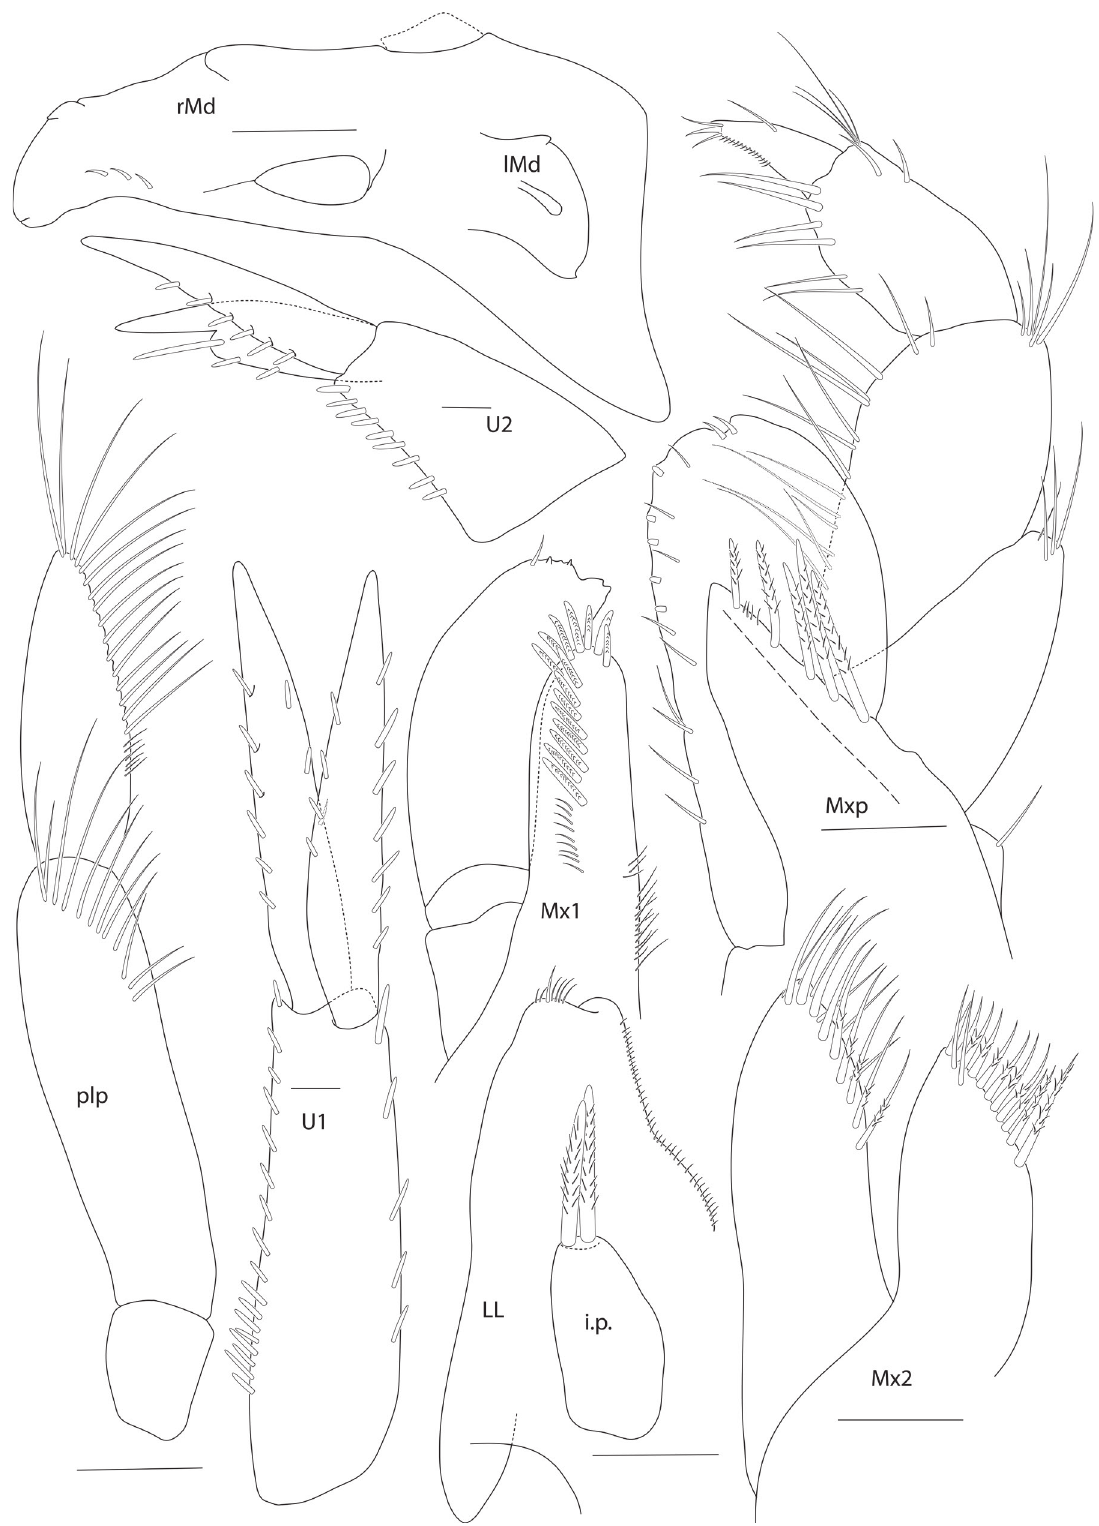
Fig. 7. Onisimus turgidus (Sars, 1879), ♀, 10 mm, Ullsfjorden (100 m depth) (TSZCr8573). Mouthparts (r and l mandible, lower lip, maxilla 1, maxilla 2, maxilliped), uropod 1. Abbreviations: see Material and methods. Scale bars = 0.1